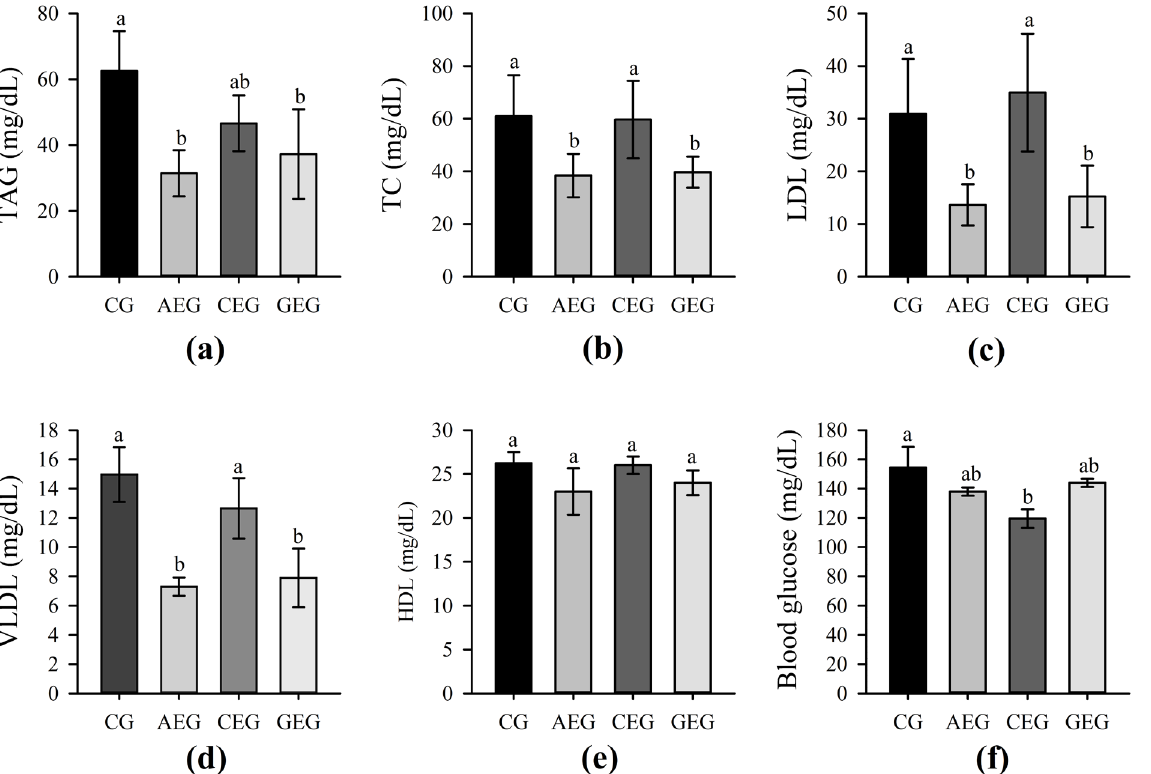
Figure 3. Lipid profile (a-e) and blood glucose (f) of rats supplemented or not with acerola, cashew, or guava by-products. a,b Different lowercase letters in vertical bars indicate a significant difference between the mean ± standard deviation of each rat group (one-way ANOVA, P ≤ 0.05, Tukey’s post hoc test; n = 8 rats/group). CG = control group; AEG= acerola by-product experimental group; CEG = cashew by-product experimental group; GEG= guava by-product experimental